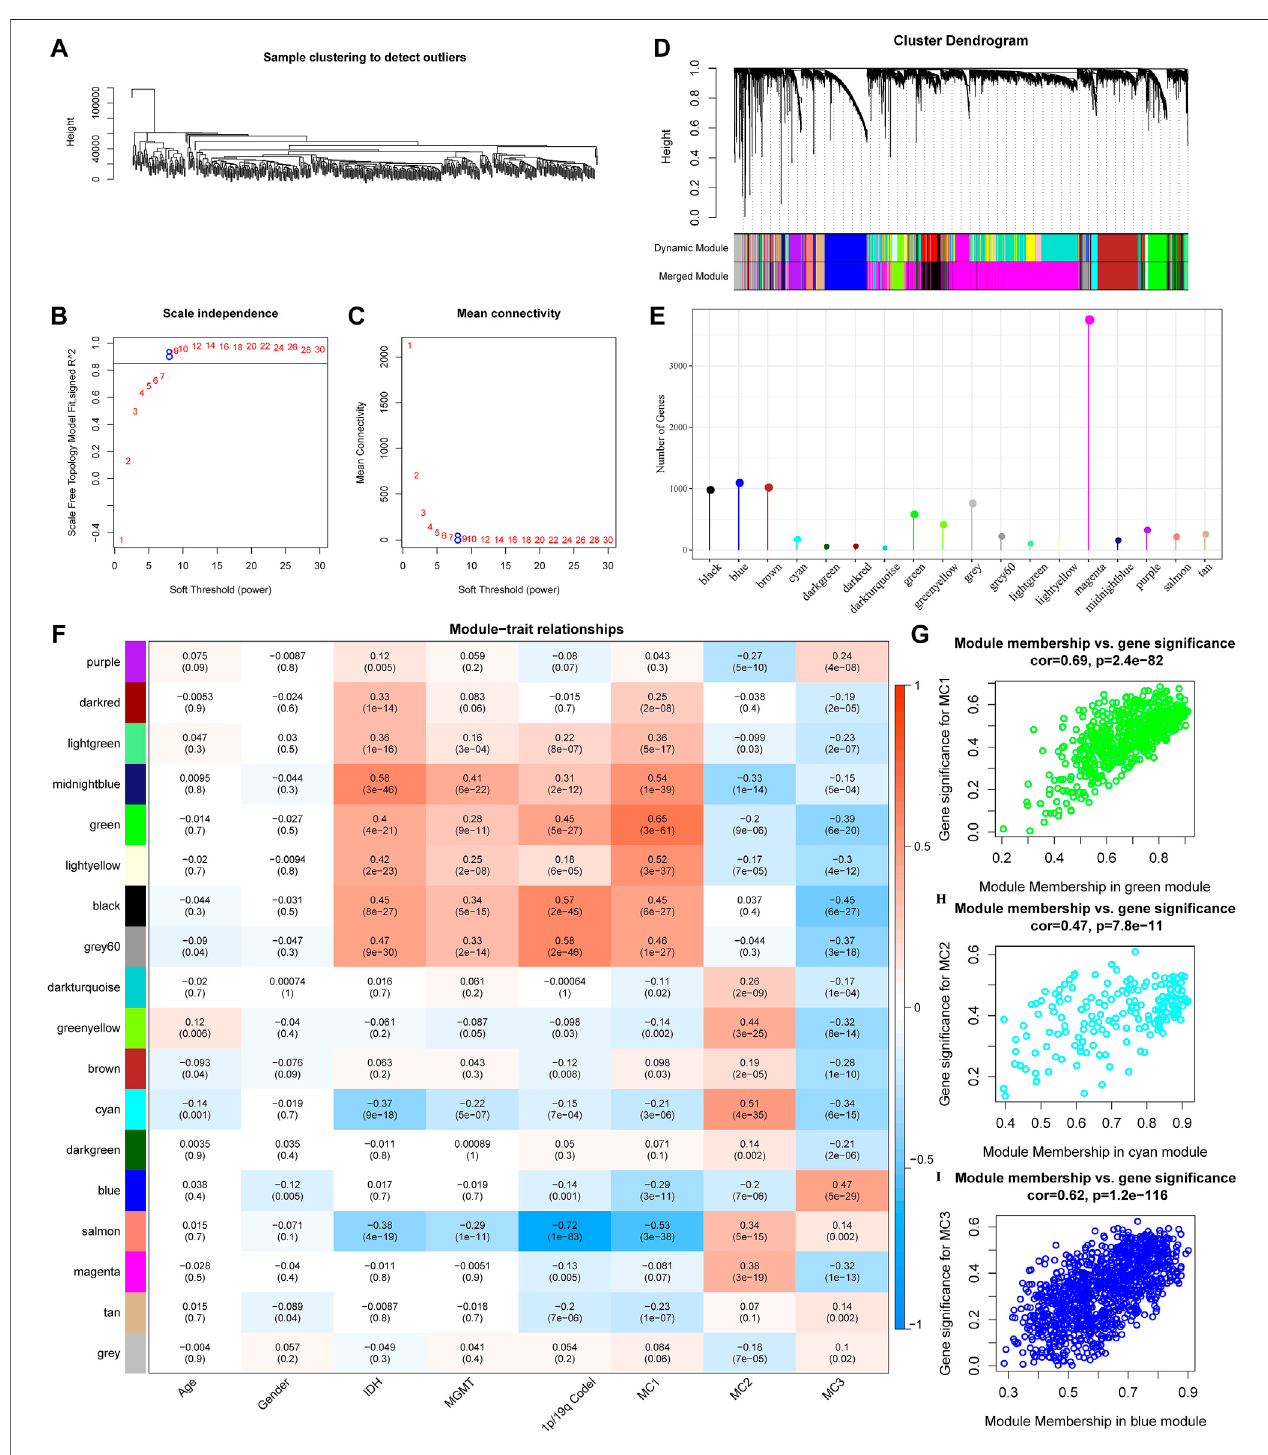
FIGURE 6 | Co-expressed gene modules identi fi cation. (A) Clustering tree of each sample. (B) The scale-free fi t index for various soft-thresholding powers ( β ). (C) The mean connectivity for various soft-thresholding powers. (D) Dendrogram of all differentially expressed genes/lncRNAs, clustered based on a dissimilarity measure. (E) Co-expression module gene statistical results. (F) Correspondence between each module and clinical information. (G) Scatter diagram for module membership vs gene signi fi cance for MC1 in the green module. (H) Scatter diagram for module membership vs gene signi fi cance for MC2 in the cyan module. (I) Scatter diagram for module membership vs gene signi fi cance for MC3 in the blue module.